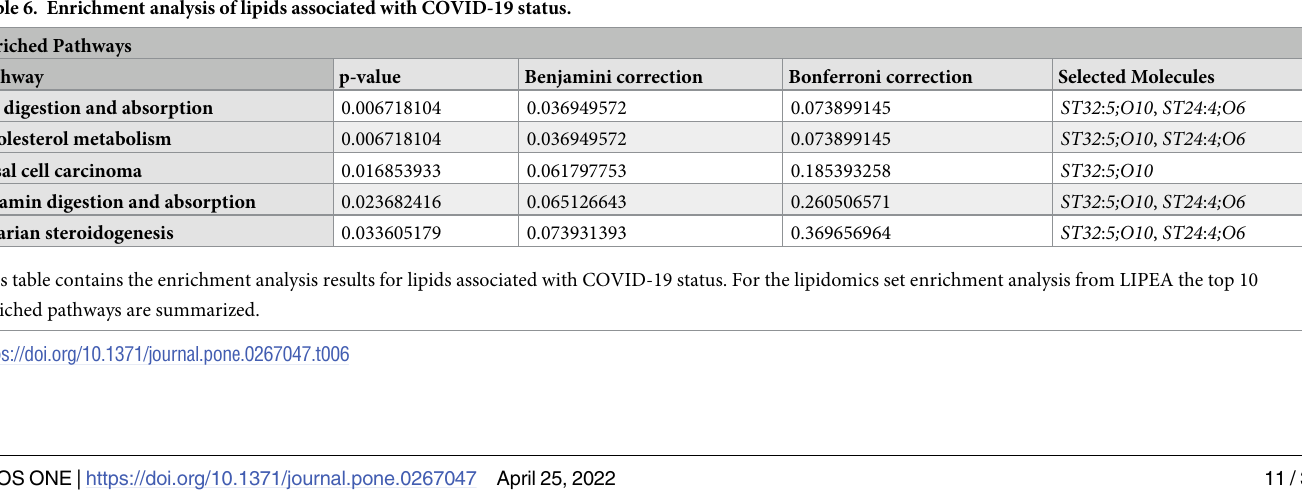
This table contains the enrichment analysis results for metabolites associated with COVID-19 status. For the metabolite set enrichment analysis the IPA output contains the top five canonical pathways and top ten biological functions and disease associations.